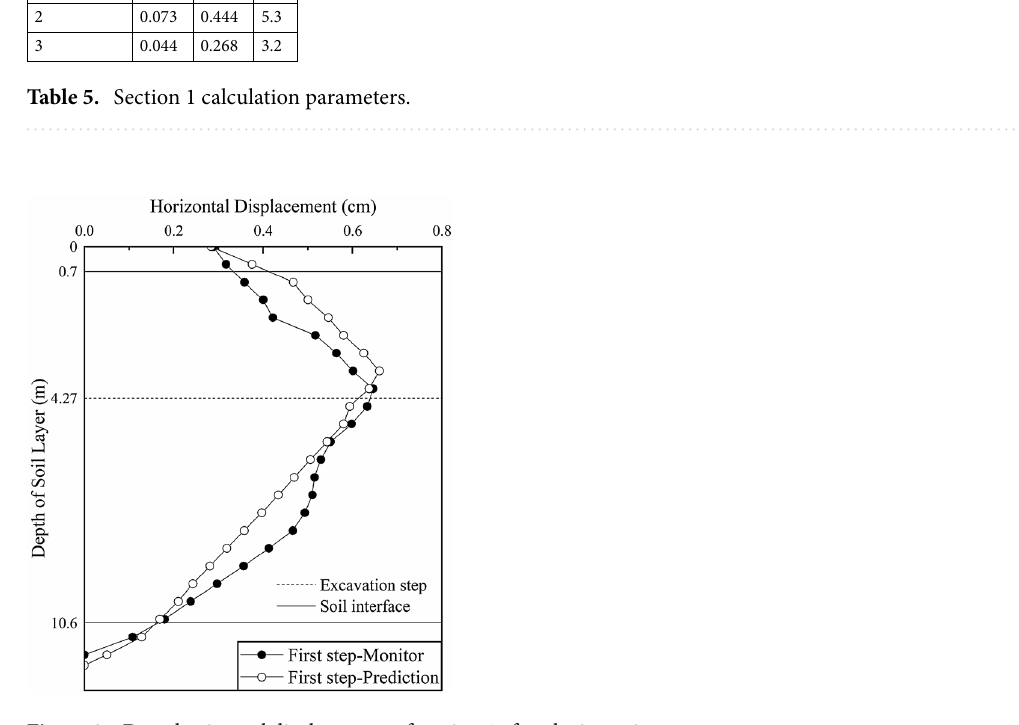
Figure 9. Deep horizontal displacement of section 1 after the